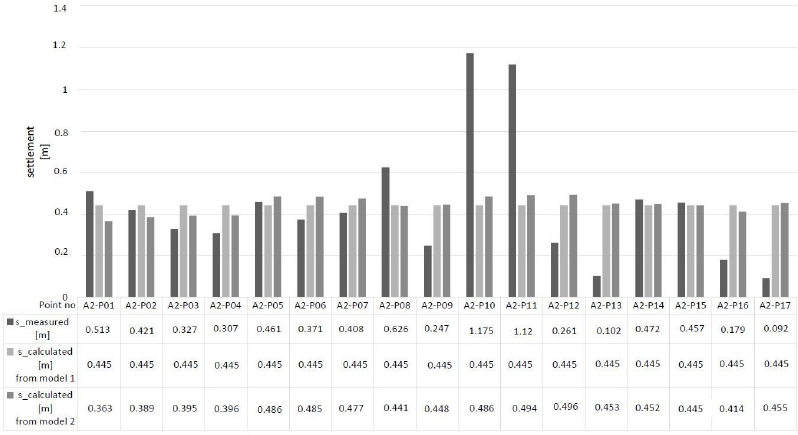
Figure 26. The representative values of the constrained modulus of elasticity for the peat layer, according to the method used.